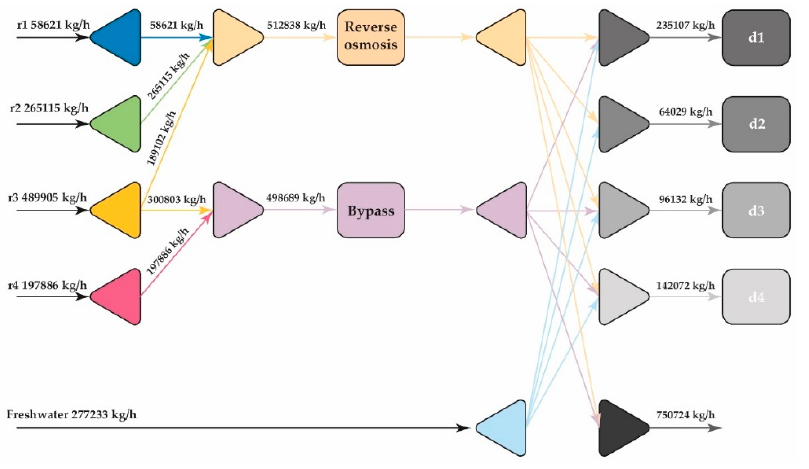
Figure 8. Optimal design for the water network.